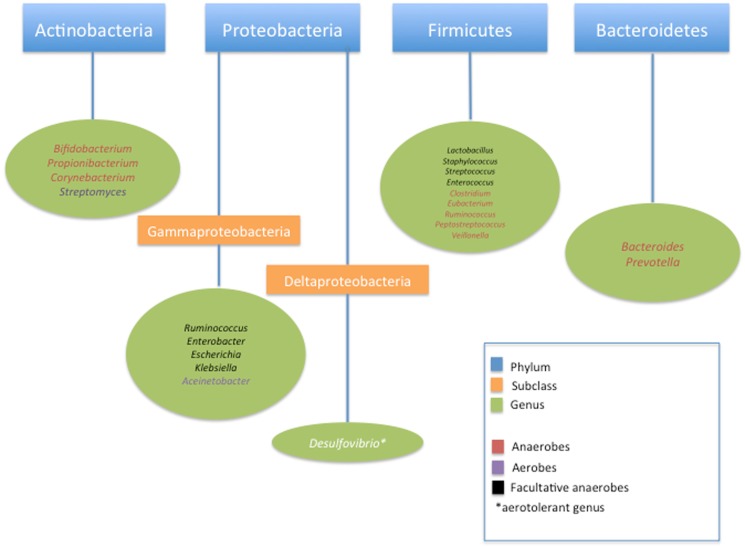
Classification of common bacteria found in neonatal intestinal microbiome.